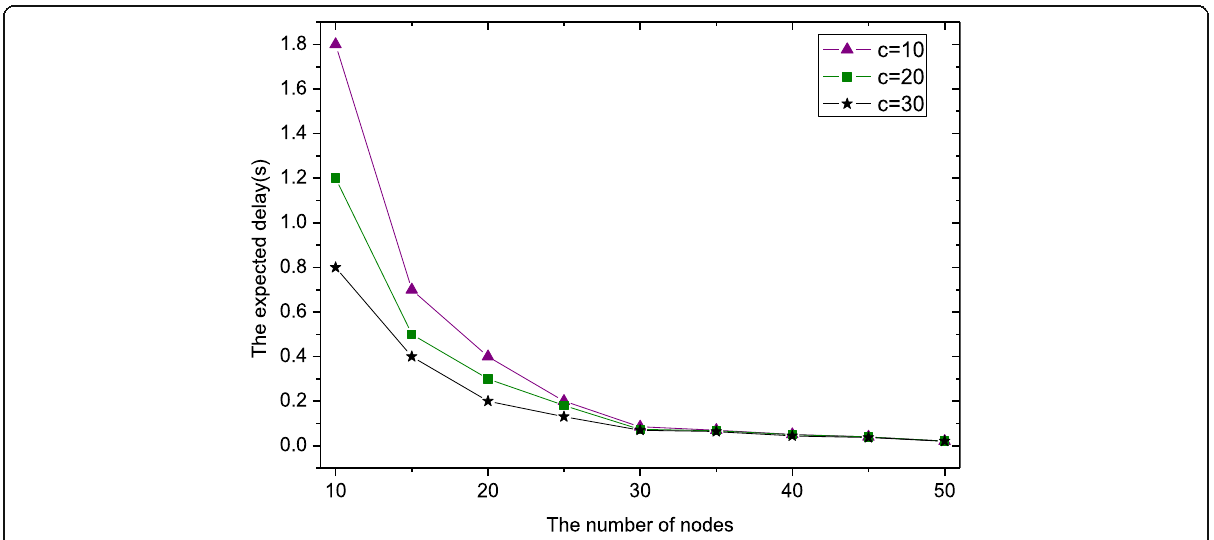
Fig. 7 The expected delay under different number of